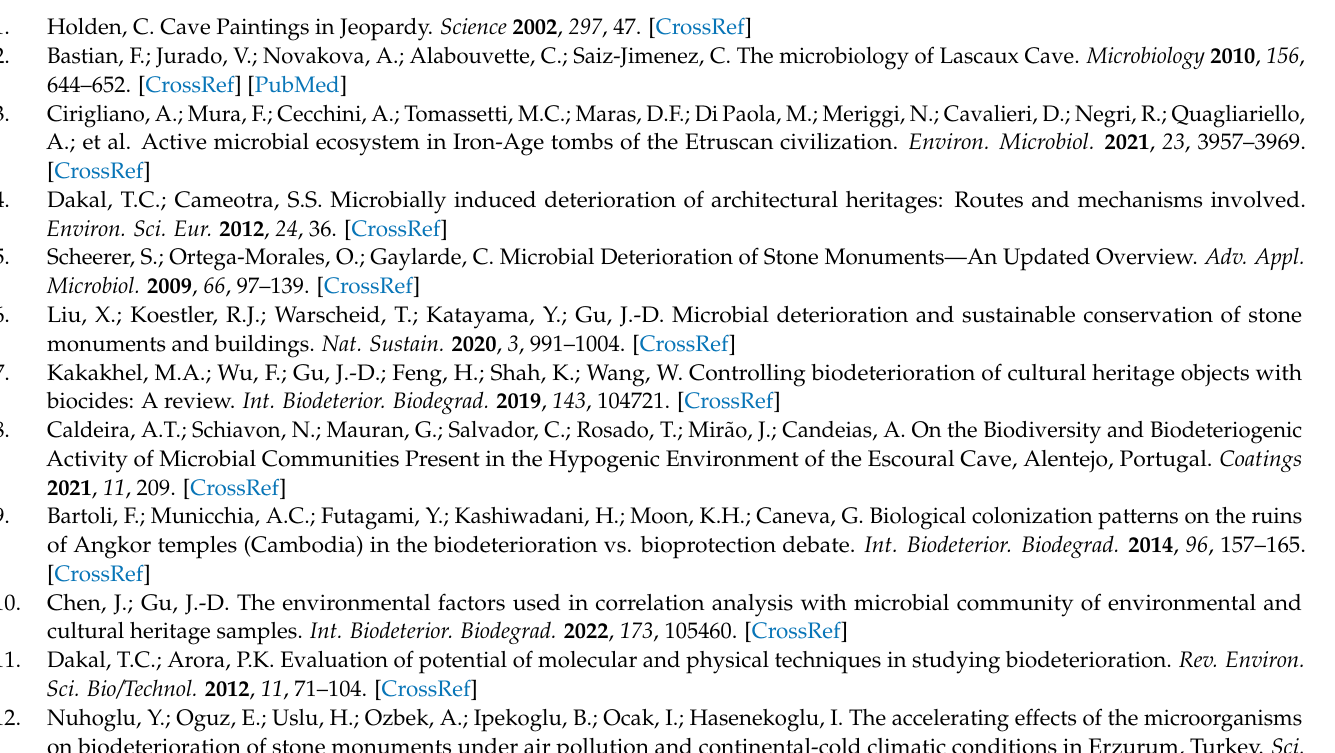
(B). Figure S2: Endemic OTUs taxa in the back room of Qinling Mausoleum. (A) Venn plot of OTUs taxa between soil outside the mausoleum and the back room of Qinling Mausoleum. (B) Heat map of family level species annotation of endemic OTUs for the top 20 abundances in Qinling Mausoleum back